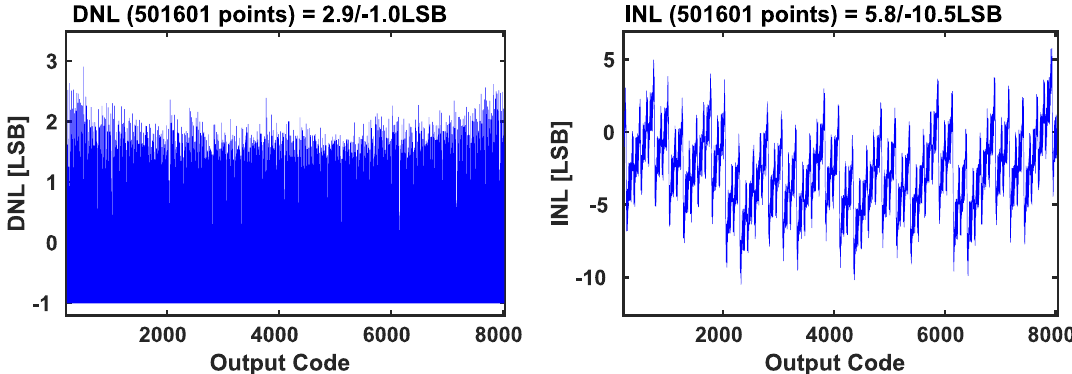
Figure 13. Static performance of prototype SAR ADC.